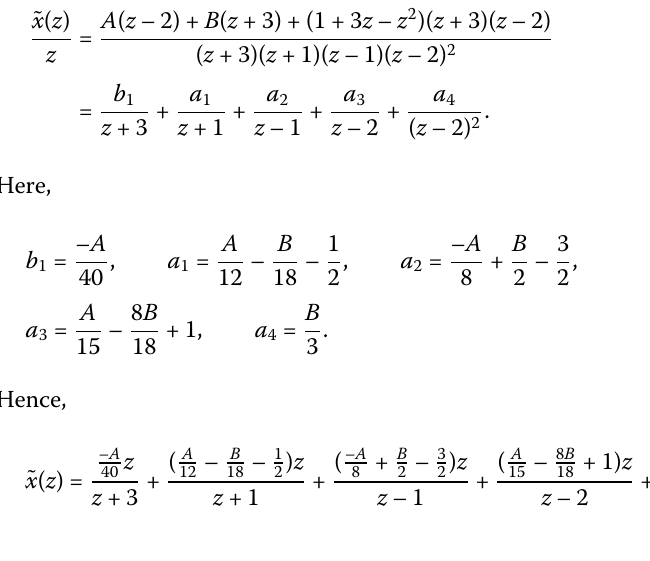
Partial fraction of ˜ x ( z )/ z